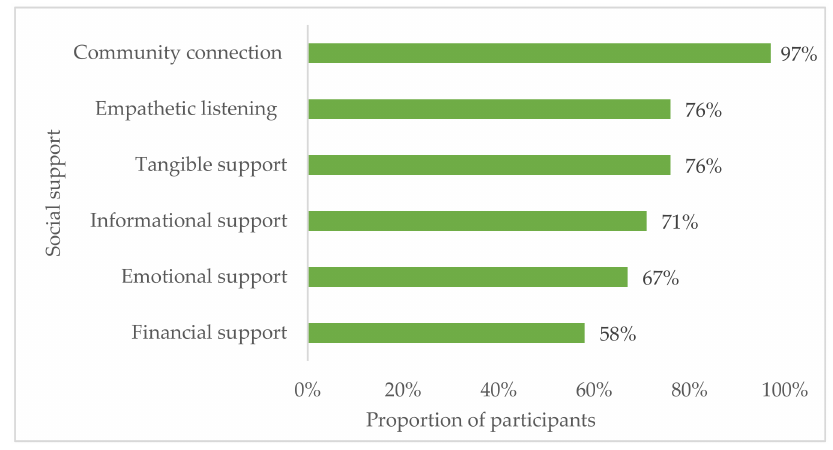
Figure 5. The availability of social support during the last 12